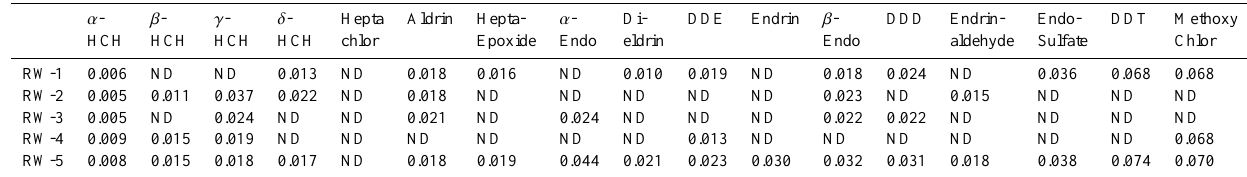
Table 8. Organochlorine residues ( µ gl − 1 ) in ground water (Ranny well) of Palla area during post-monsoon seasons. α -